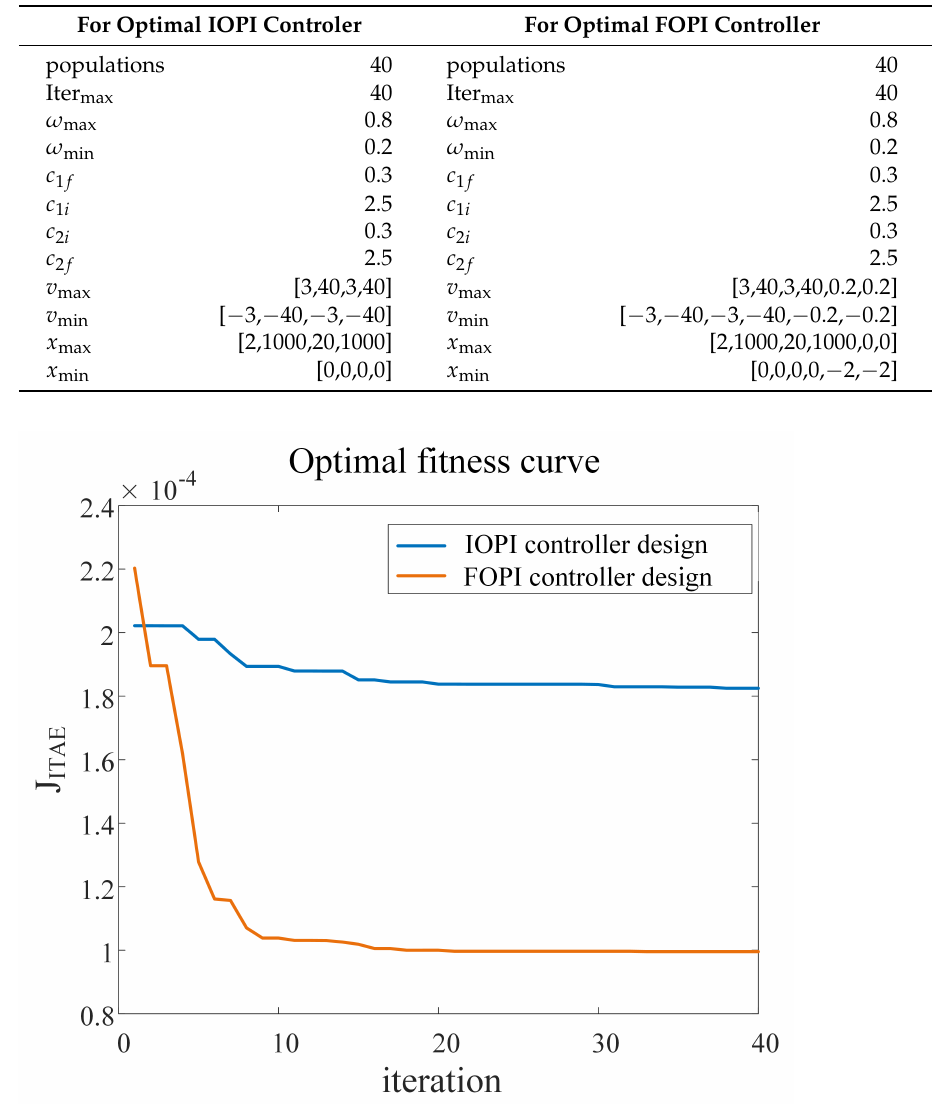
Figure 8. PSO algorithm Optimal fitness function value in FOPI/IOPI controller